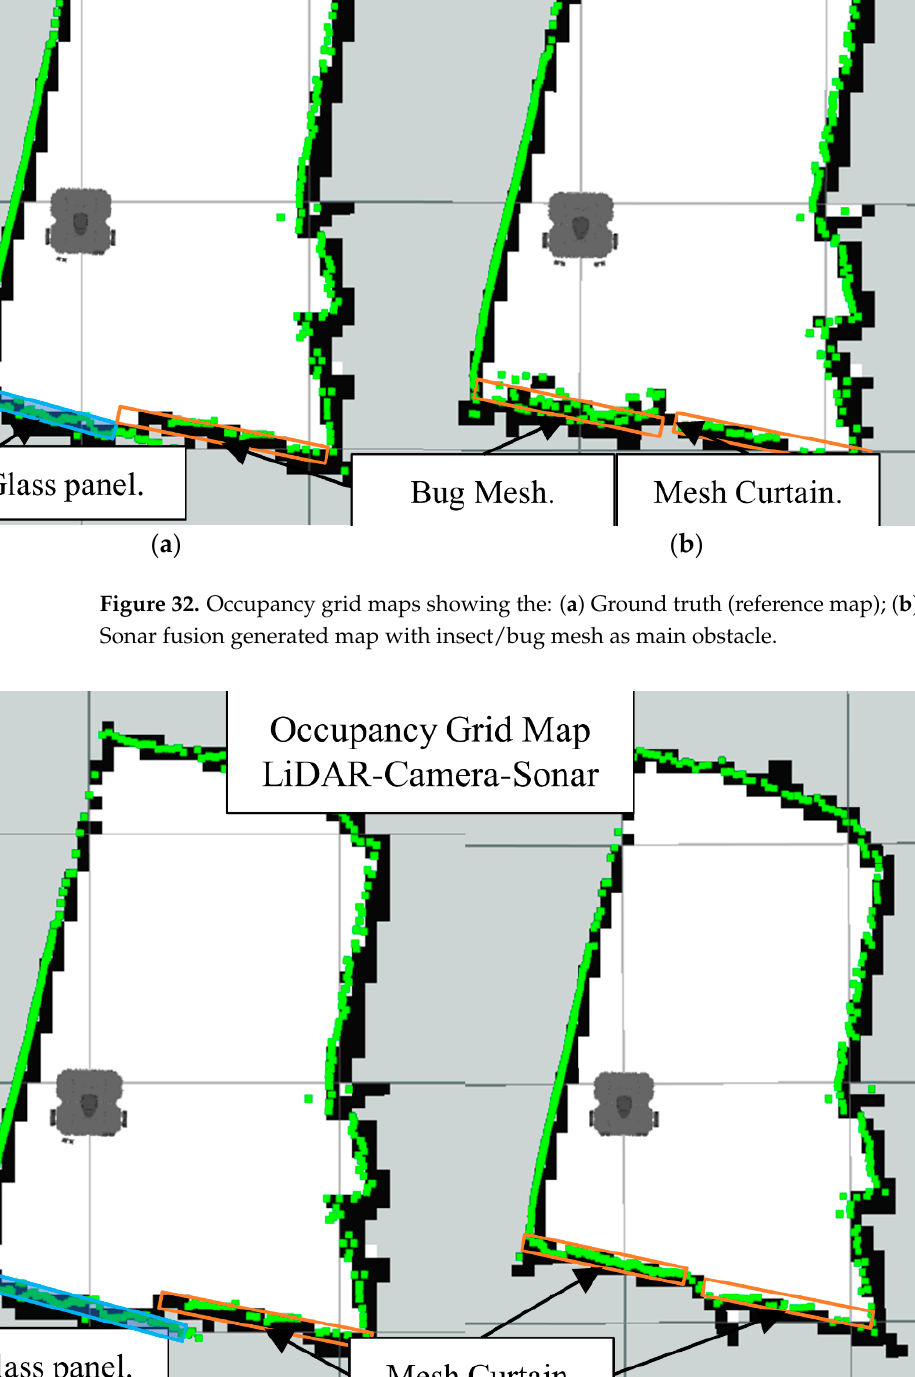
Figure 33. Occupancy grid maps showing the: ( a ) Ground truth (reference map); ( b ) LiDAR-Camara-Sonar fusion generated map with mesh curtain as main obstacle.